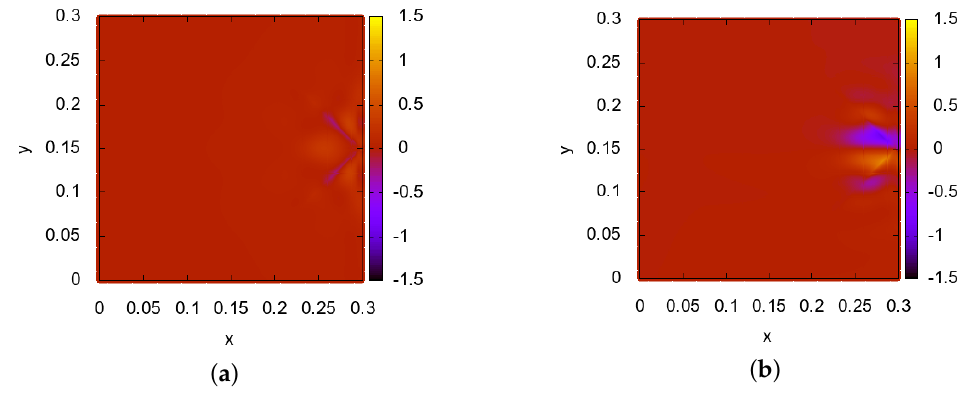
Figure 7. Test 2. Inverse problem 2. Numerical solution. 900 iterations. ( a )—computed solution q 1 ( x , y ) . ( b )—computed solution q 2 ( x , y ) . Figure 8 considers the inverse problem data for a narrow sector. The sector moves from the middle of the side to the corners of the opposite one. The top of the sector is right on the border.